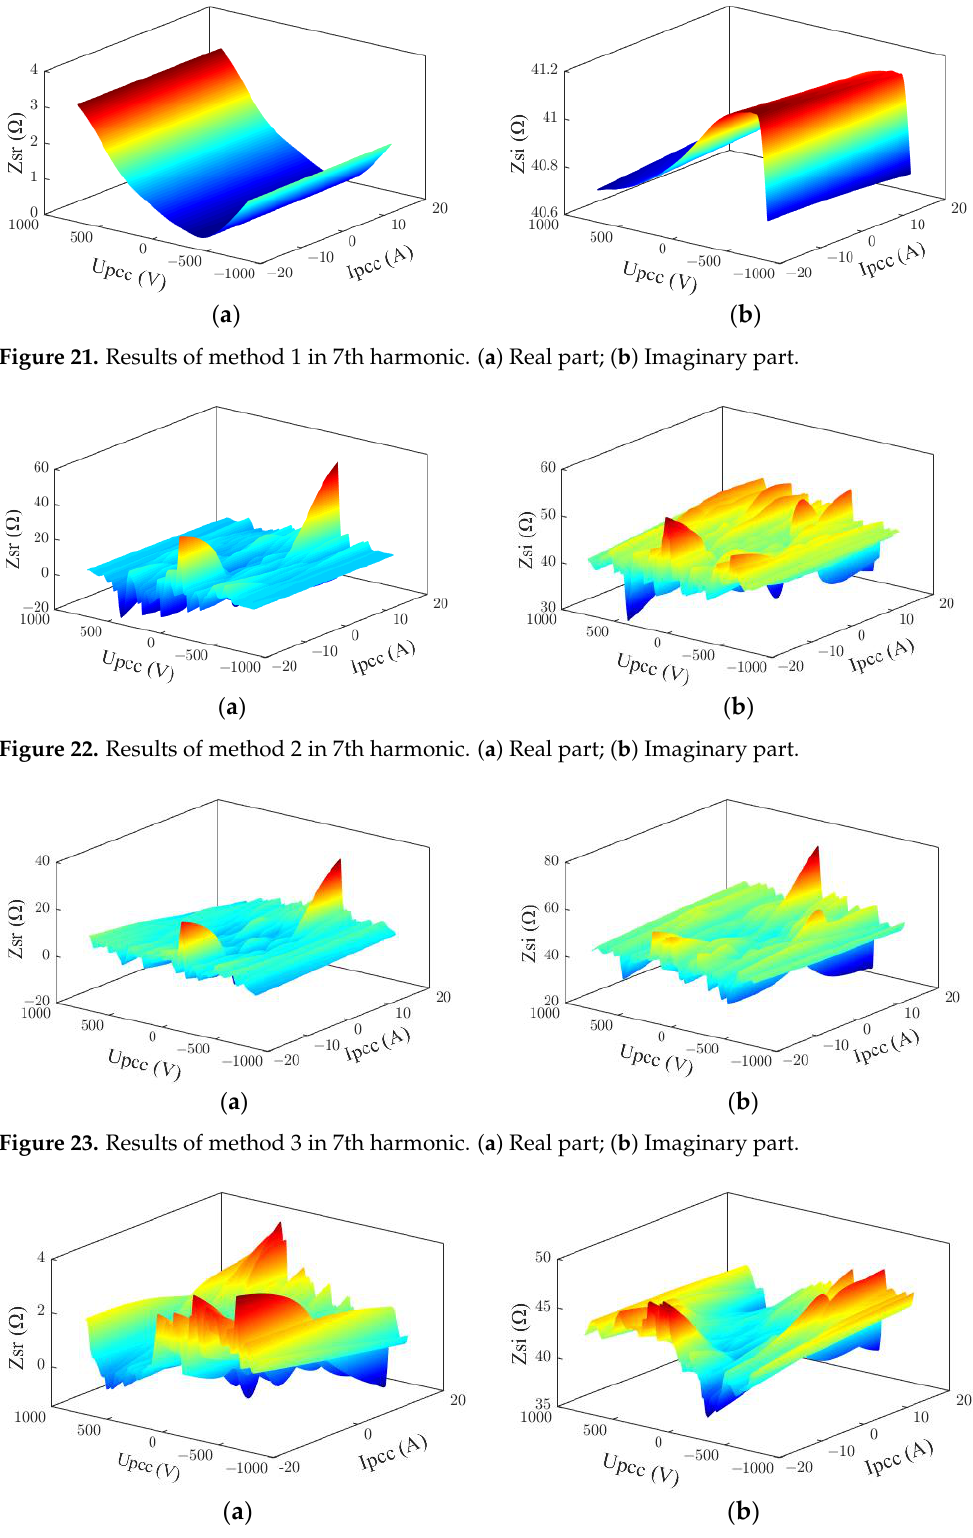
Figure 21. Results of method 1 in 7th harmonic. ( a ) Real part; ( b ) Imaginary part. Table 8. Evaluation indexes of method 1 in 7th harmonic.